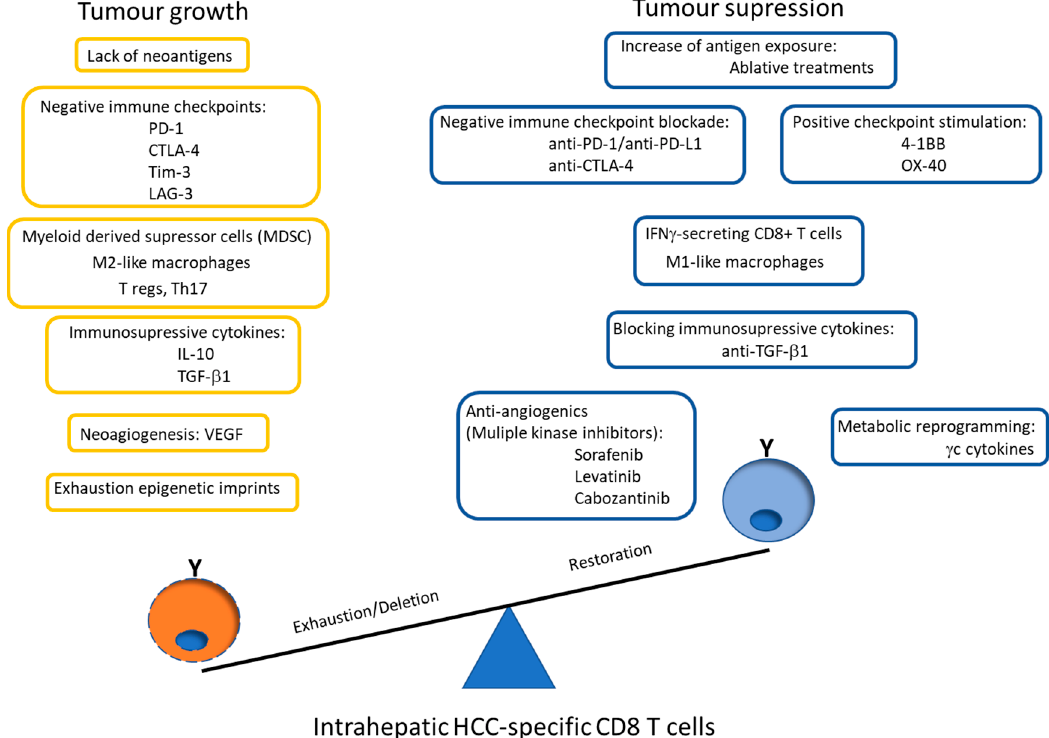
Figure 3. Scheme showing the potential mechanisms involved in HCC-specific CD8 T cell impairment. The graph also highlights the possible PD-1/PD-L1 blockade-based combination therapies to rescue effector and precursor HCC-specific cytotoxic T cell response. PD-1: programmed cell death protein 1, CTLA-4: cytotoxic T lymphocyte antigen-4, Tim-3: T cell immunoglobulin domain and mucin domain, LAG-3: lymphocyte-activation gene 3, T regs: CD4 T regulatory cells, Th: T helper, IL: interleukin, TFG: tumor growth factor, VEGF: vascular endothelial growth factor, 4-1BB: tumor necrosis factor receptor superfamily member 9, OX-40: Tumor necrosis factor receptor superfamily member 4, γ c: gamma-chain.